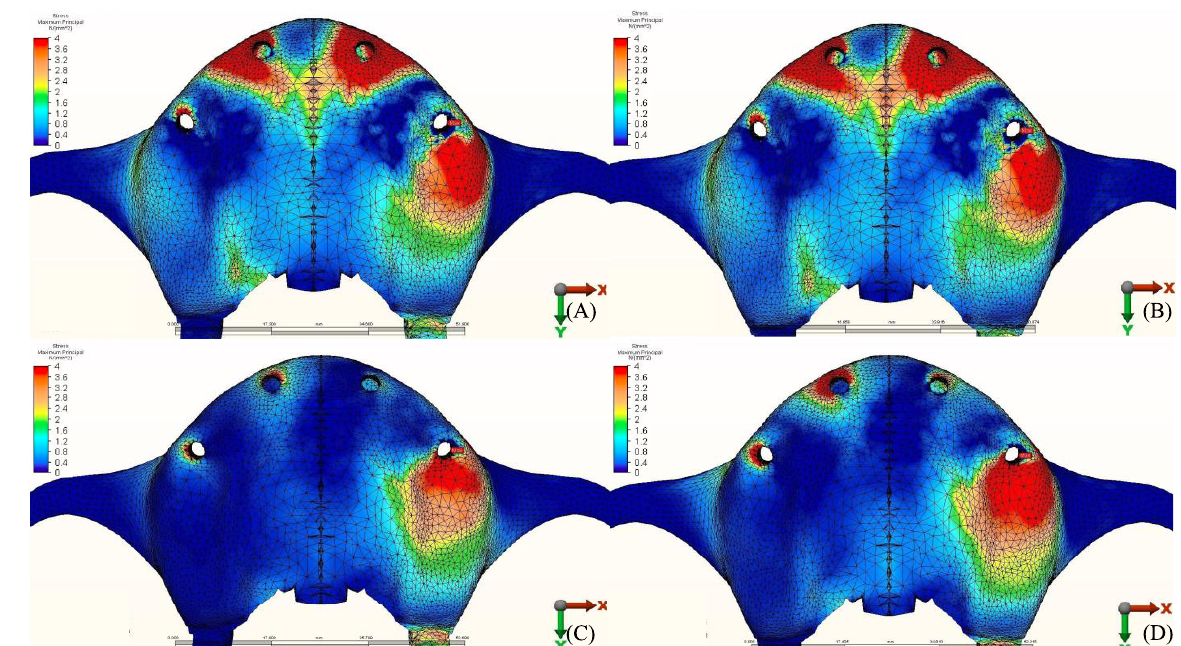
Figure 7. Pmax stress distribution in cortical bone for group 3, PEEK bar with composite resin gingiva and ceramic superstructure with zirconium (Toronto bridge). ( A ) Model 3.1, opposing natural tooth. ( B ) Model 3.2, opposing tooth-supported full ceramic crown. ( C ) Model 3.3, opposing acrylic prosthesis with titanium framework. ( D ) Model 3.4, opposing implant-supported full ceramic crown.